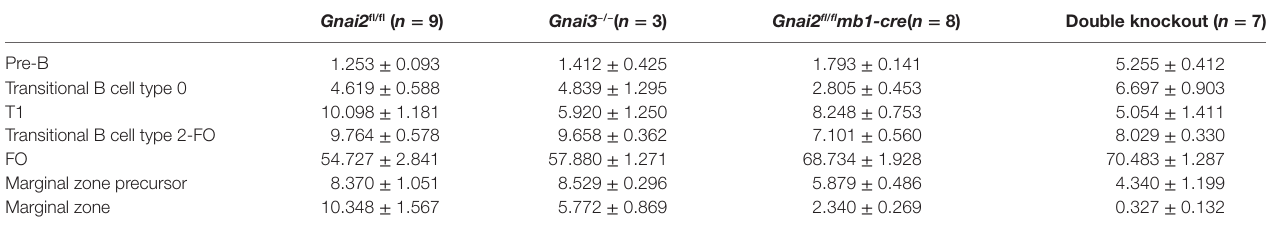
TaBle 1 | Splenic B cell subsets in G α i -deficient